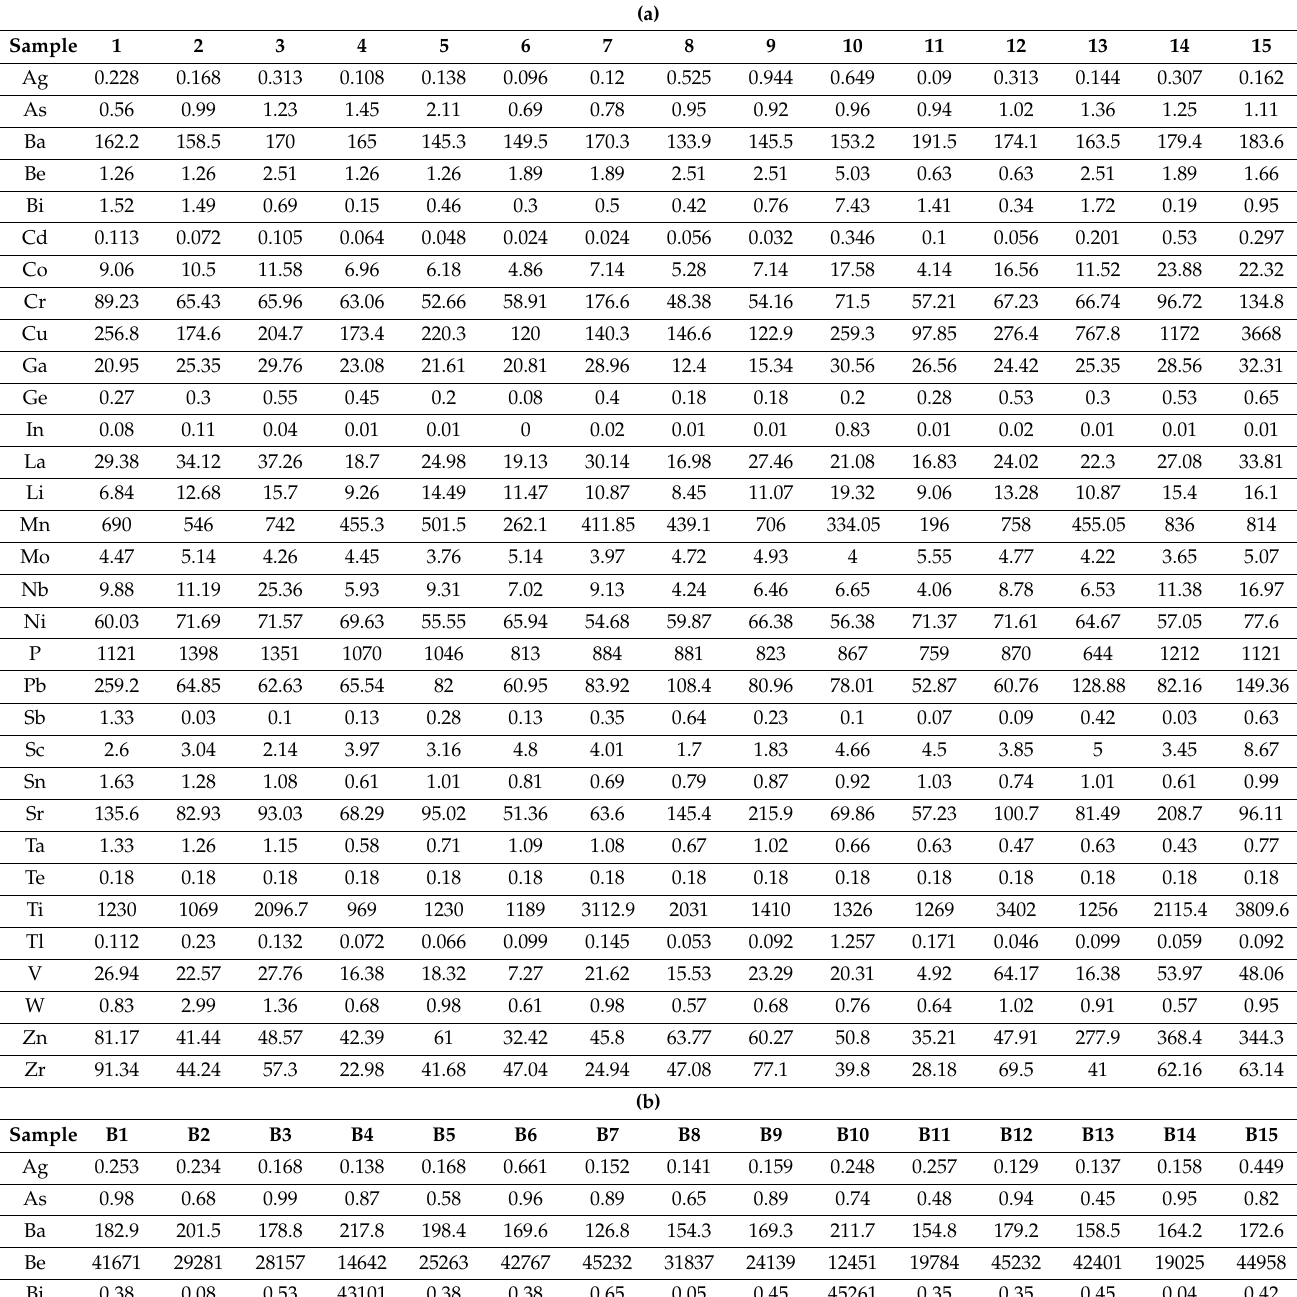
Table 4. (a). Chemical composition of lake water within Burabay Rock mass (ppm). (b) Chemical composition of bottom deposits from the lakes within Burabay Rock mass